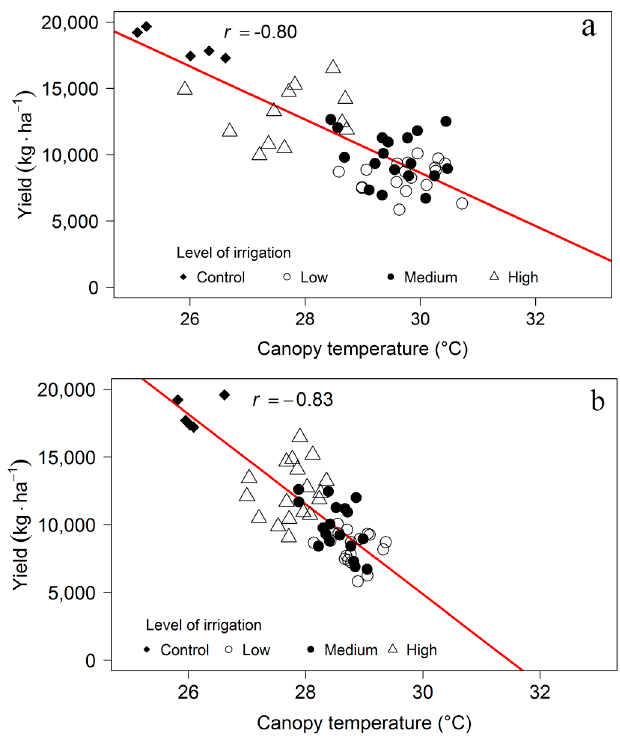
Figure 12. Correlation between canopy temperature and yield at ( a ) 80 and ( b ) 44 DBH.